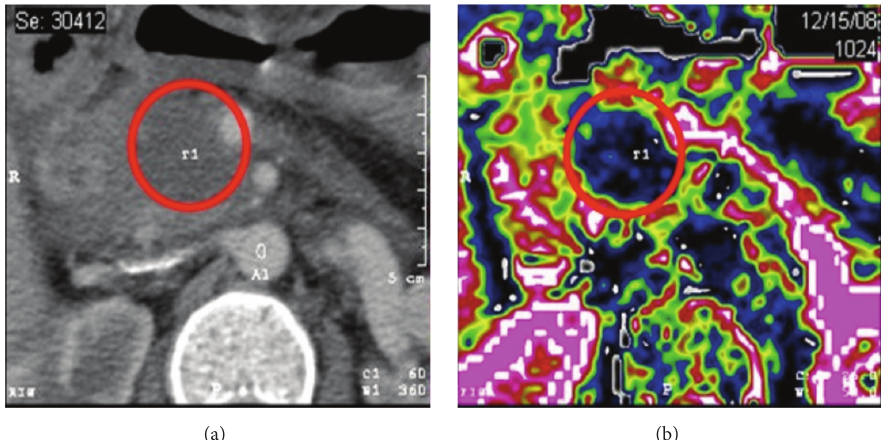
Figure 3: (a) Preoperative CT-scan of a locally advanced pancreatic cancer. (b) Post-RFA perfusion CT-scan, showing a postablative area of decreased perfusion within the head of the pancreas. Copyright Chirurgia del Pancreas Verona.